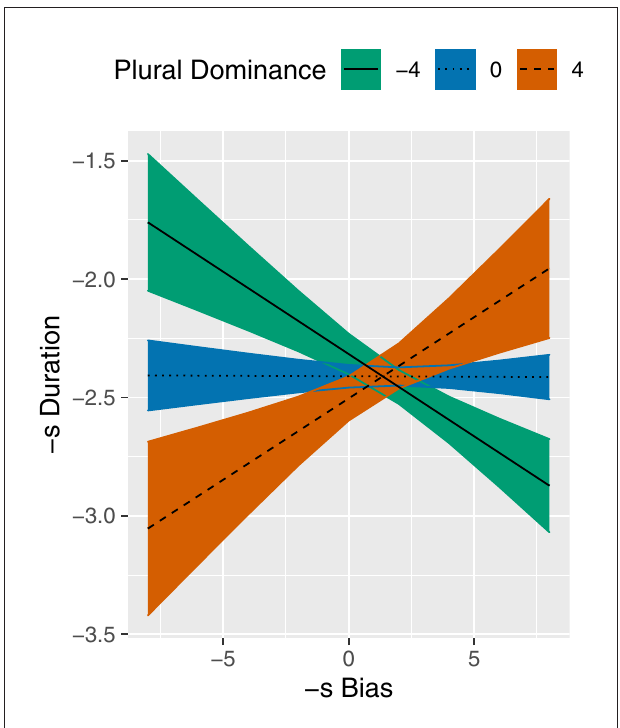
FIGURE 3 | Partial effect plot for the -S BIAS × PLURAL DOMINANCE interaction in the model of -S DURATION . Coloured bands reflect 95% confidence intervals.